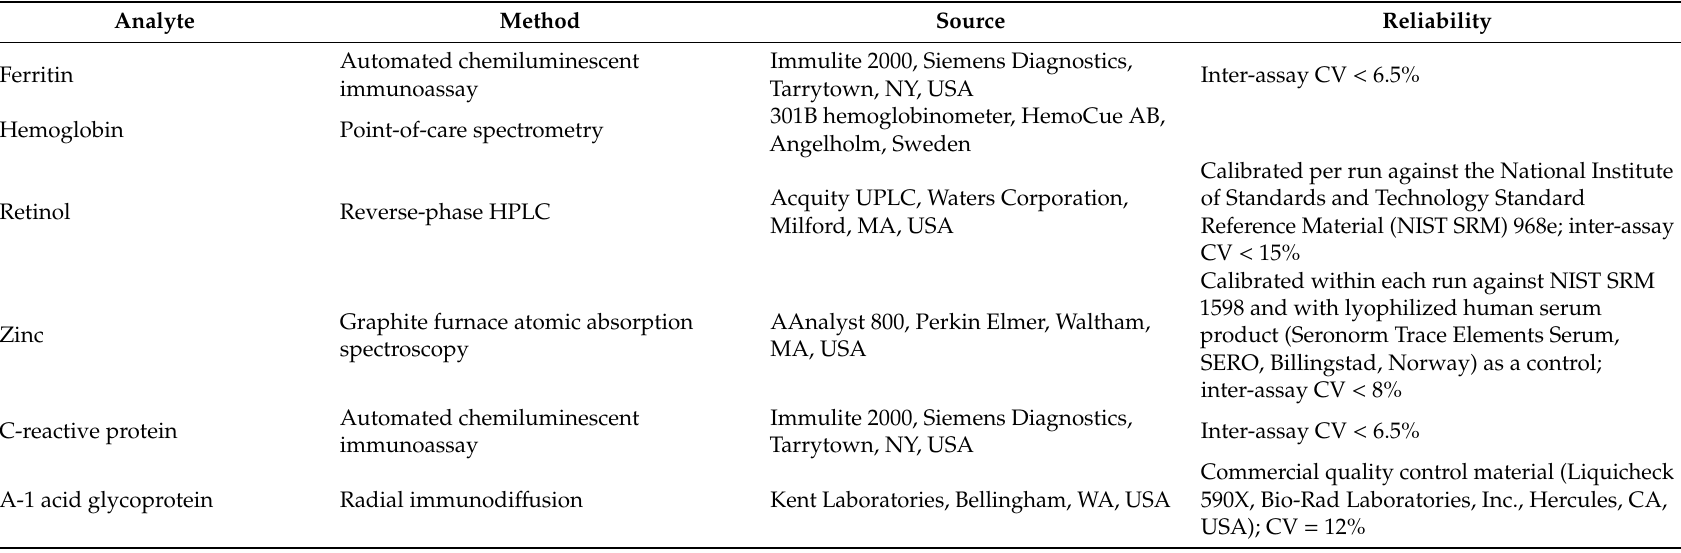
Table 1. Laboratory methods